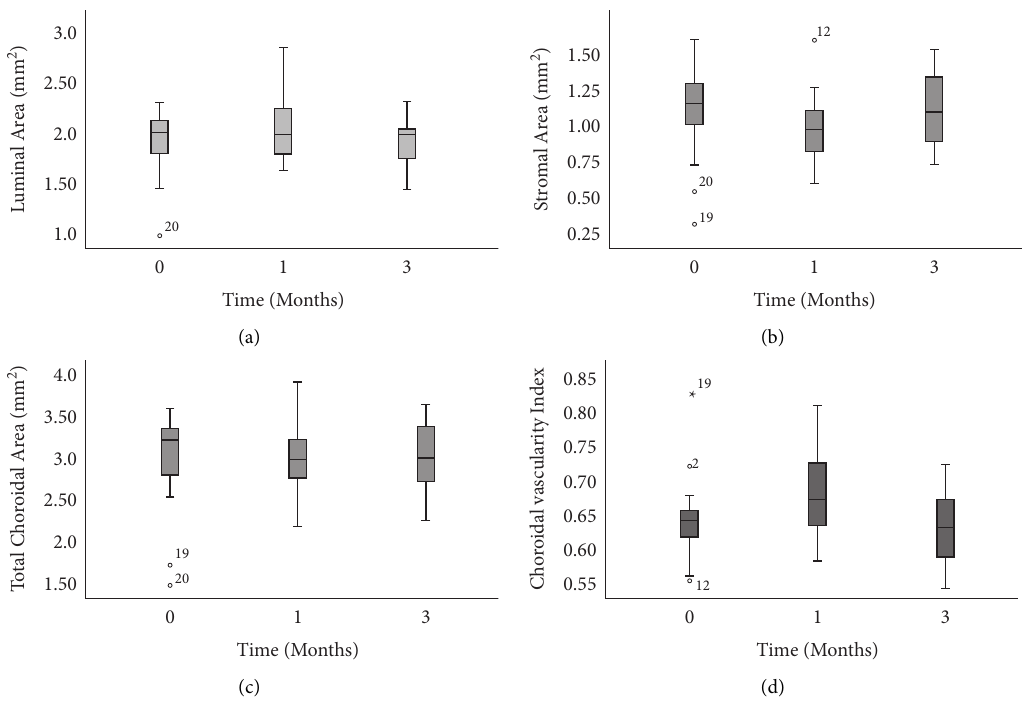
Figure 2: Boxplots demonstrating luminal area (a), stromal area (b), total choroidal area (c), and choroidal vascularity index (d) over the study period. Zero-point indicates recovery from the disease, and 1 and 3 indicate 1 and 3months after the first visit. The luminal area significantly changed between 1 and 3 months, while the stromal area demonstrated significant changes between baseline and first month. The total choroidal area remained comparable between the study periods while CVI increased significantly between the baseline and first month and then returned to baseline values after 3months.